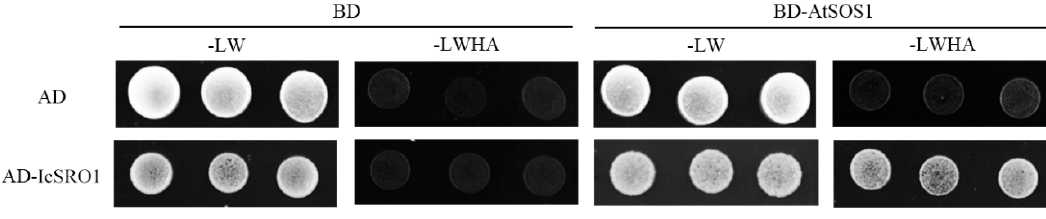
Figure 8. Interaction of IcSRO1 with AtSOS1 determined by yeast cell growth on synthetic dropout (SD) medium lacking Leu, Trp, His, and Ade (SD-LW HA).